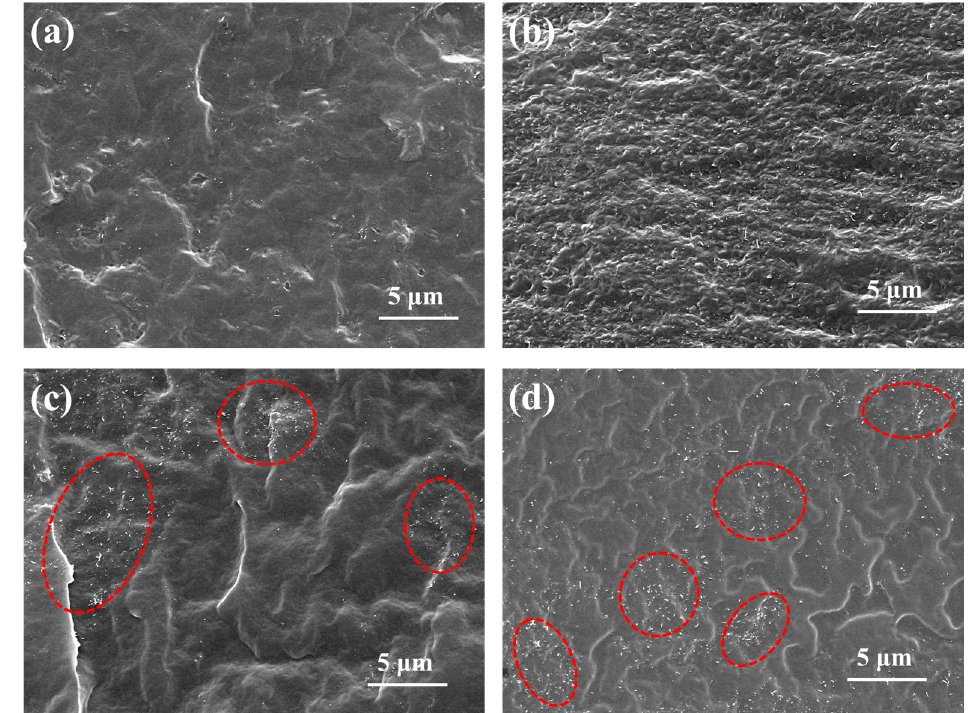
Figure 3. SEM images of the G–CNT/EVA composites with ( a ) 0.3 wt % and ( b ) 2.0 wt % CNT, respectively. SEM images of the CNT/EVA composites with ( c ) 0.3 wt % and ( d ) 2.0 wt % CNT, respectively. The red circles in ( c ) and ( d ) refer to the CNT agglomerations.